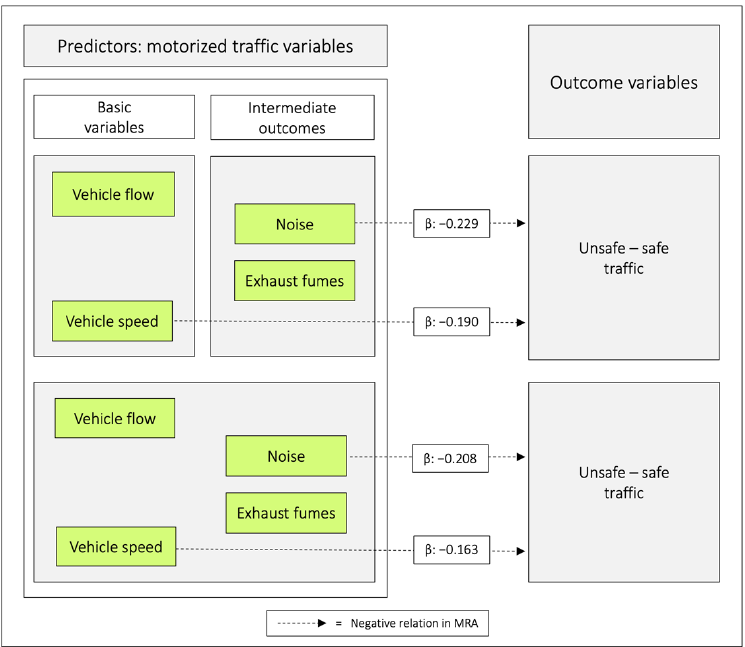
Figure 9. Regression coefficients between combinations of the predictor variables in relation to un ‐ safe–safe traffic . Notes: β = unstandardized beta. The figure is based on Table 8.